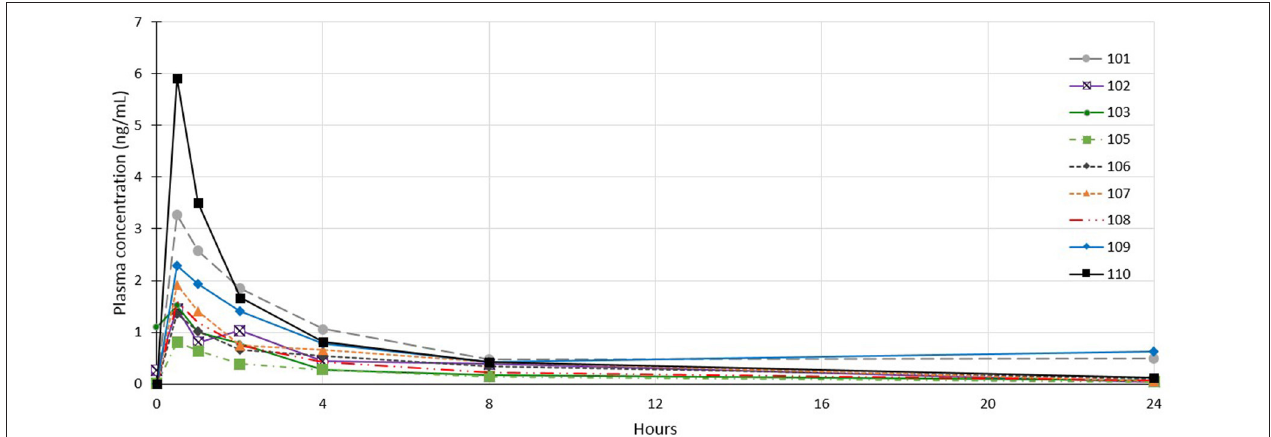
FIGURE 3 | Individual plasma concentration curves for dogs in cohort 1 who received tigilanol tiglate (1 mg/mL).